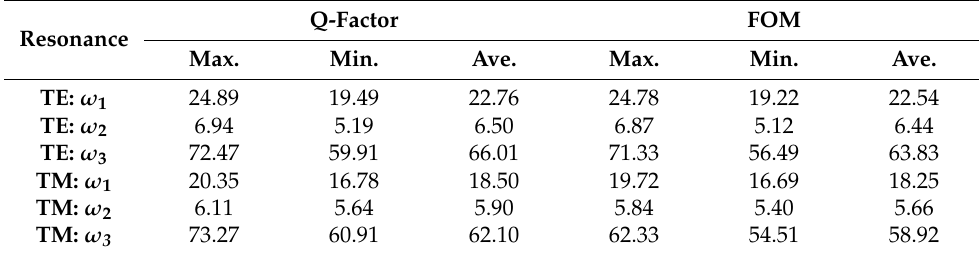
Figure 10. Electromagnetic responses of the TTM exposed on the surrounding ambient with different refraction index ( n ) in ( a ) TE and ( b ) TM modes, where L , R , and h parameters are kept as constants at 47.5 µ m, 40 µ m, and 0 µ m, respectively. ( c ) and ( d ) are the Q-factors and FOMs of TTM in TE and TM modes, respectively. Table 1. Summaries of Q-factors and FOMs of TTM.